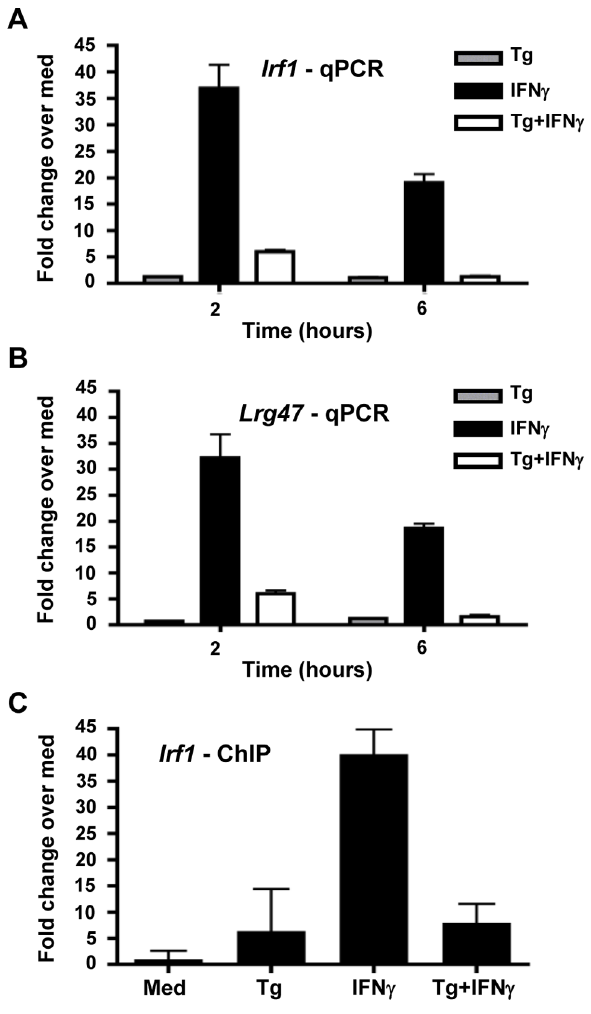
Figure 5. Toxoplasma blocks IFN c -driven STAT1-dependent gene induction. BMDC were infected with the RH strain of T. gondii (Tg, ratio of 3 parasites/cell), treated with treated IFN c (100 ng/ml), or pre-infected for 2 hours with RH prior to addition of IFN c (Tg + IFN c ). At the indicated time points post cytokine treatment, total RNA was harvested and reverse-transcribed to cDNA prior to qPCR amplification of the IFN c -responsive, STAT1-dependent genes Irf-1 (A) and Lrg-47 (B). Fold change in gene expression is expressed relative to BMDC in medium alone. Samples were normalized to the house-keeping gene GAPDH. To assess native chromatin binding, ChIP was performed using an anti-STAT1 a antibody followed by qPCR amplification with primers specific for the Irf-1 promoter (C). Experimental conditions are replicated as in (A and B), with a time point of 2 hours shown. In (C), fold change in promoter binding is expressed relative to untreated cells (Med). Samples were normalized to input chromatin. Experiments were repeated at least three times with similar